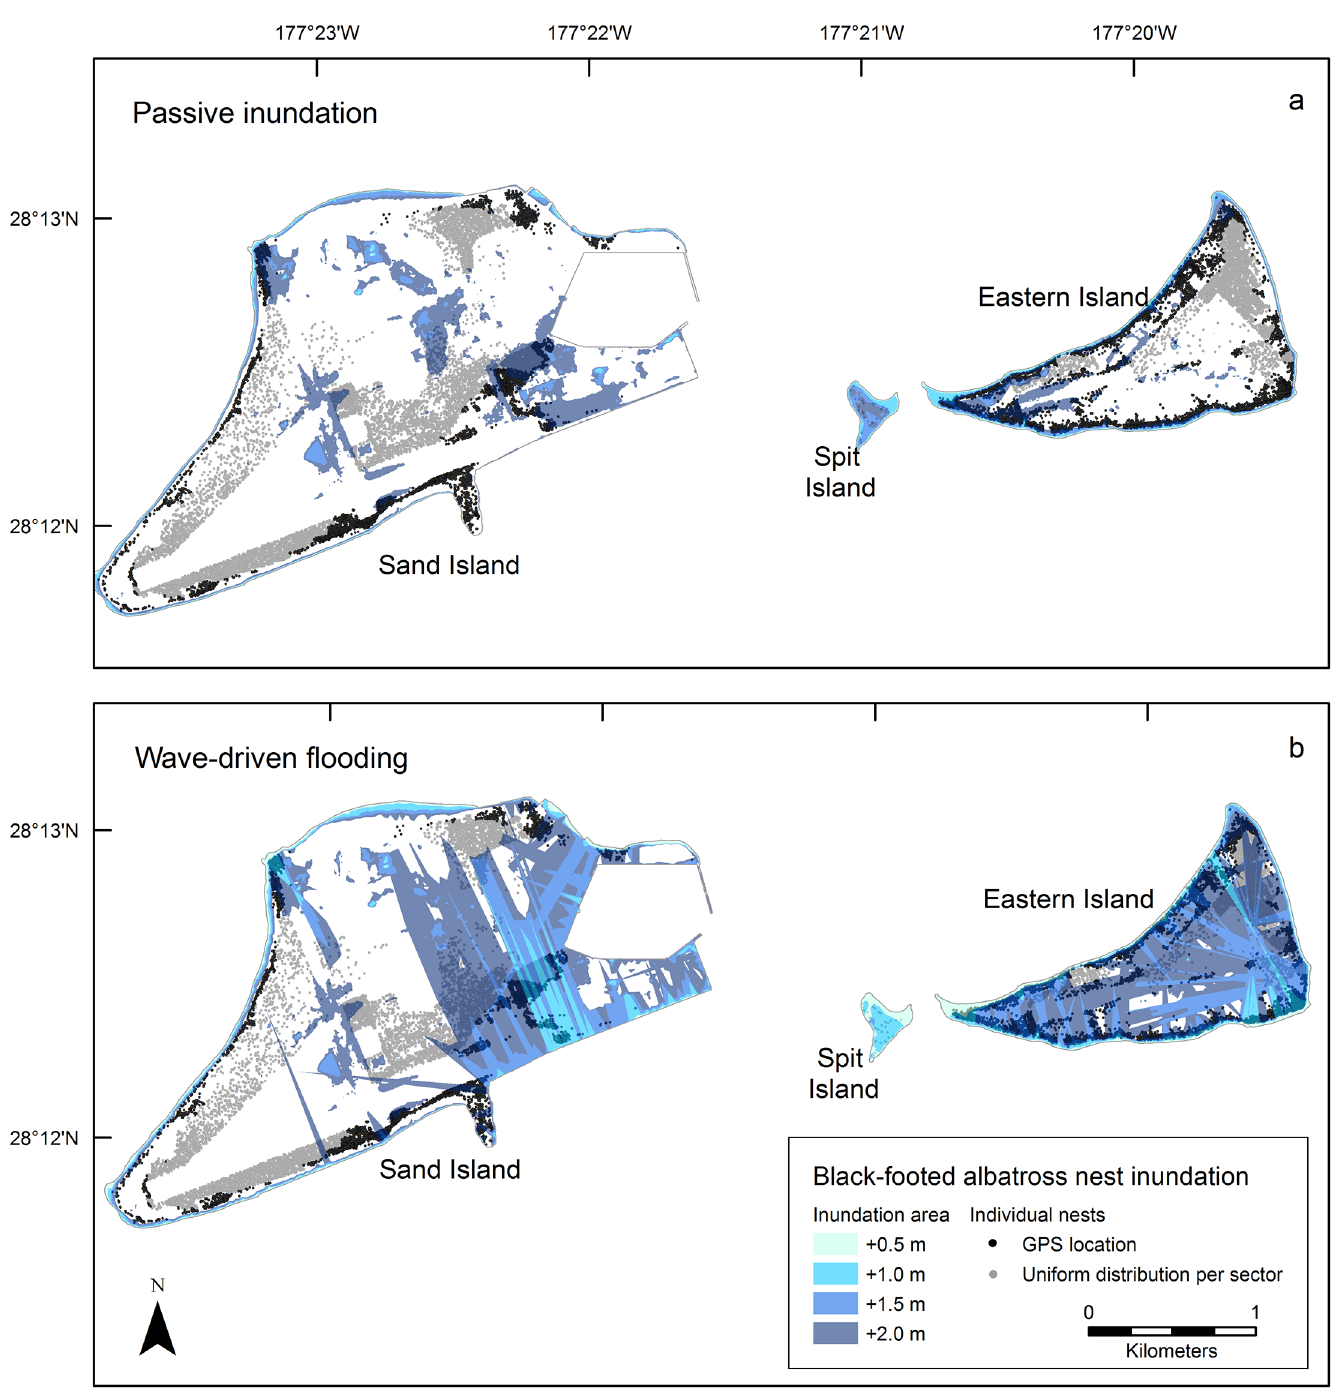
Fig 4. Projected inundation of black-footed albatross nests at Midway Atoll for four sea-level rise scenarios (+ 0.5, 1.0, 1.5, and 2.0 m) using passive (a) and wave-driven (b) models, including groundwater rise. Individual nest sites with GPS locations ( ± < 3 m accuracy) are indicated in black, approximate site locations of nests counted within census sectors are indicated in gray (assumes uniform distribution in suitable habitat [excludes infrastructure, shrubs and wetlands]).